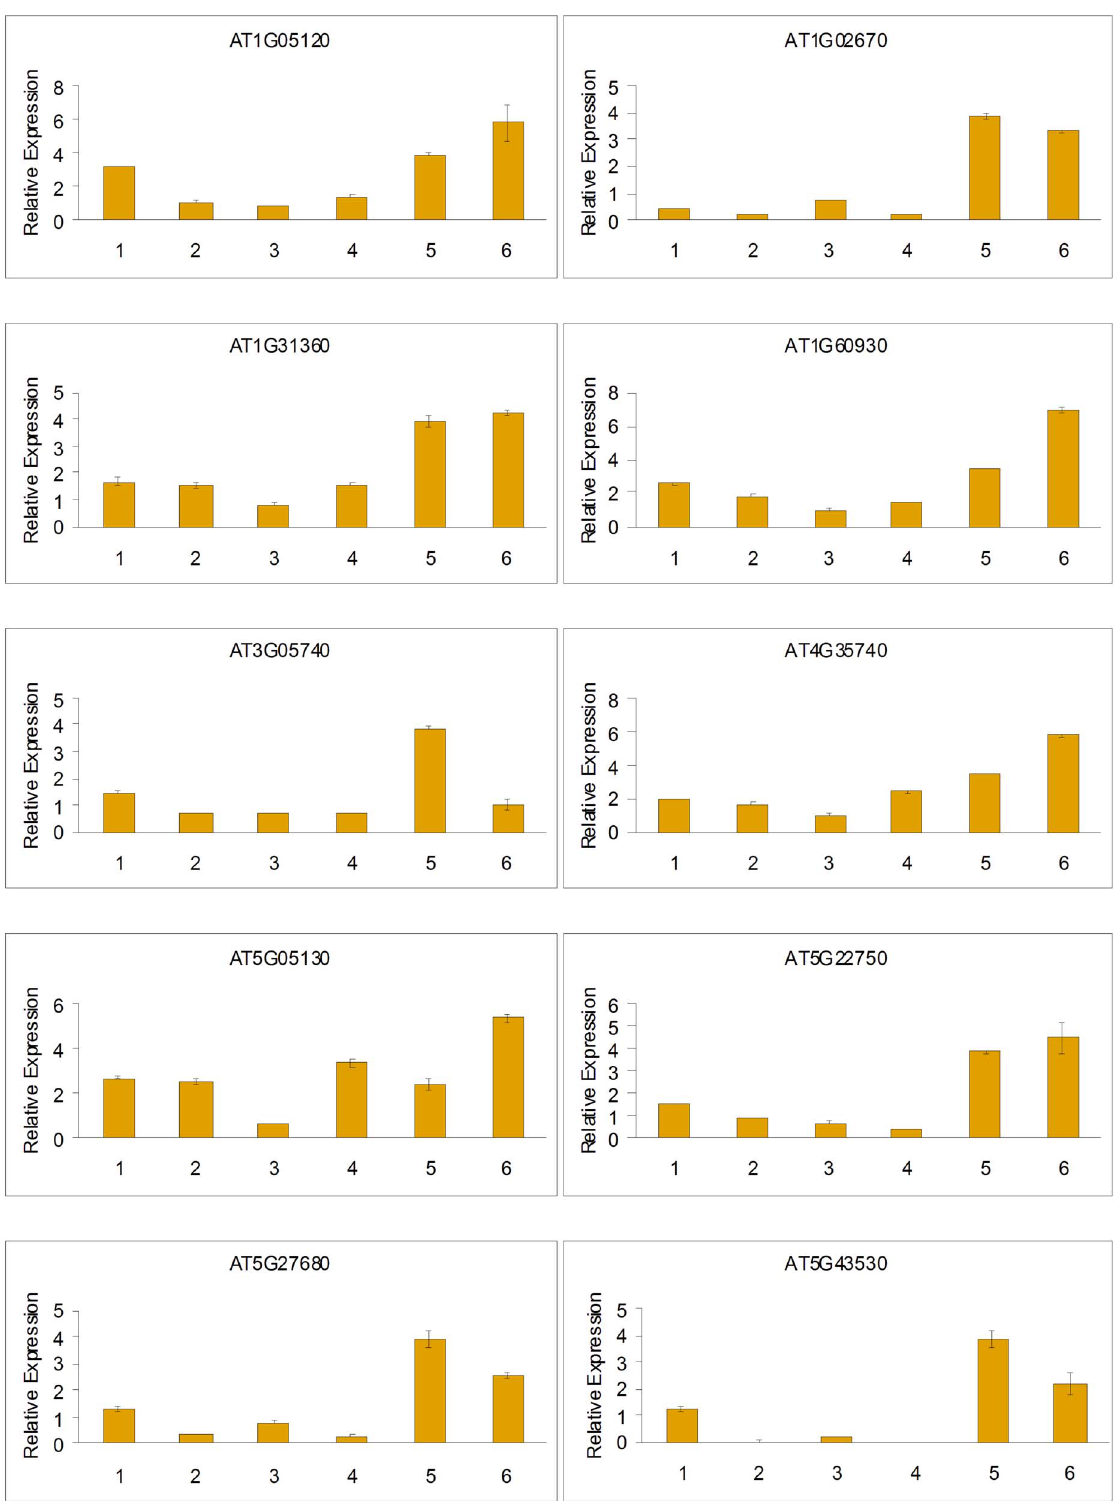
Figure 8. QRT-PCR analysis of 10 helicase genes in different tissues of Arabidopsis . Error bars indicate standard deviations (n=3). 1, root; 2, rosette leaf; 3, stem; 4, cauline leaf; 5, flower; 6, silique. splicing [55,56,57,58], the mechanisms that regulate alternative in the production of different protein isoforms, thereby affecting splicing in plants remain unknown. Alternative splicing can result transcriptome and proteome diversity, and, ultimately, the